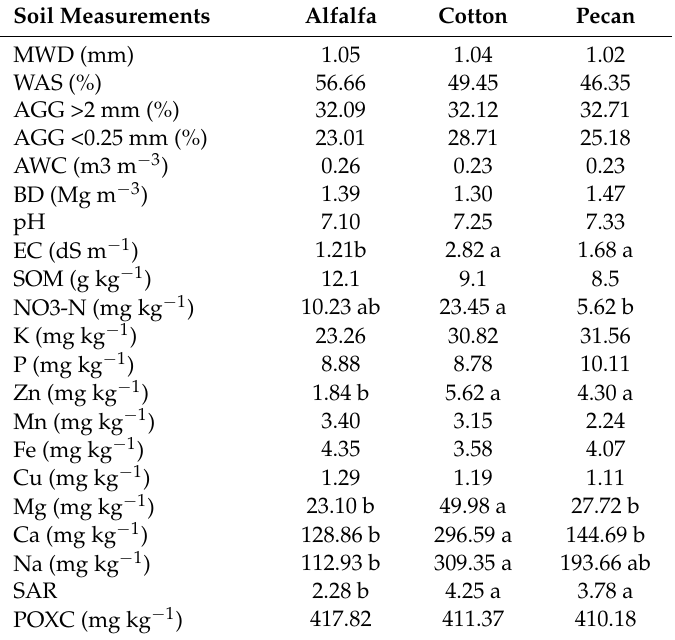
Table 4. Mean separation of the measured soil indicators as a function of crop management. Soil